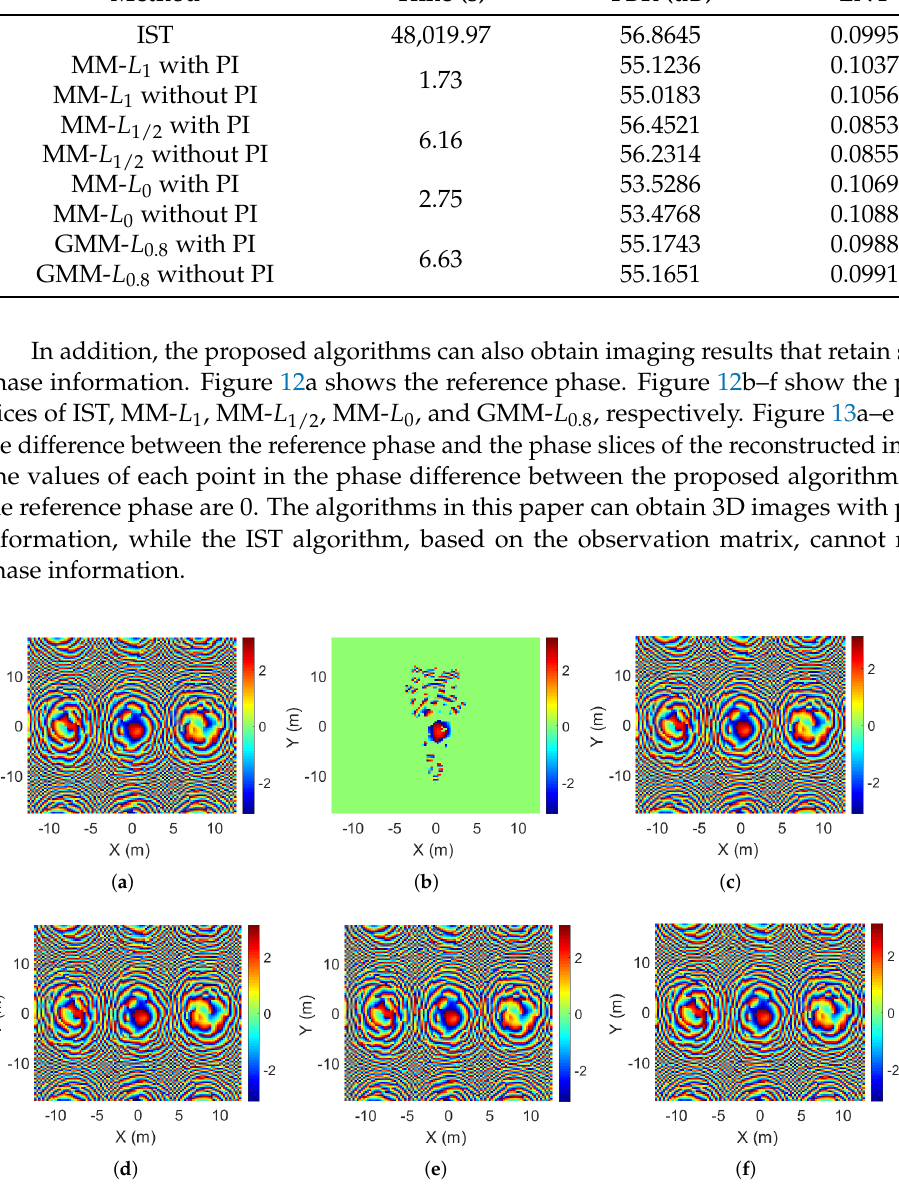
Figure 12. Phase slices. ( a ) The reference phase. ( b ) The IST result. ( c ) The MM- L 1 result. ( d ) The MM- L 1/2 result. ( e ) The MM- L 0 result. ( f ) The GMM- L 0.8